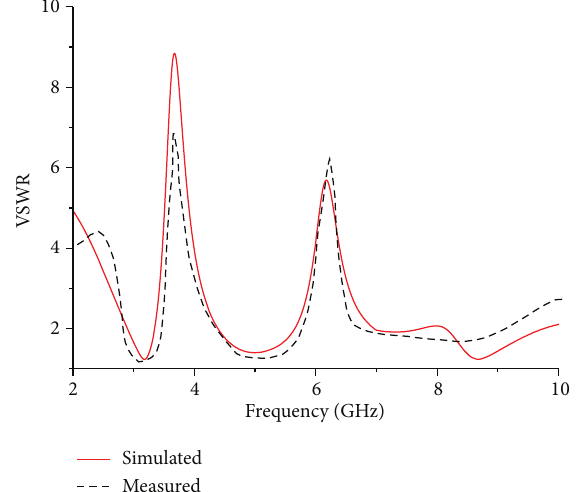
Figure 20: Simulated and measured VSWR results of the proposed antenna.